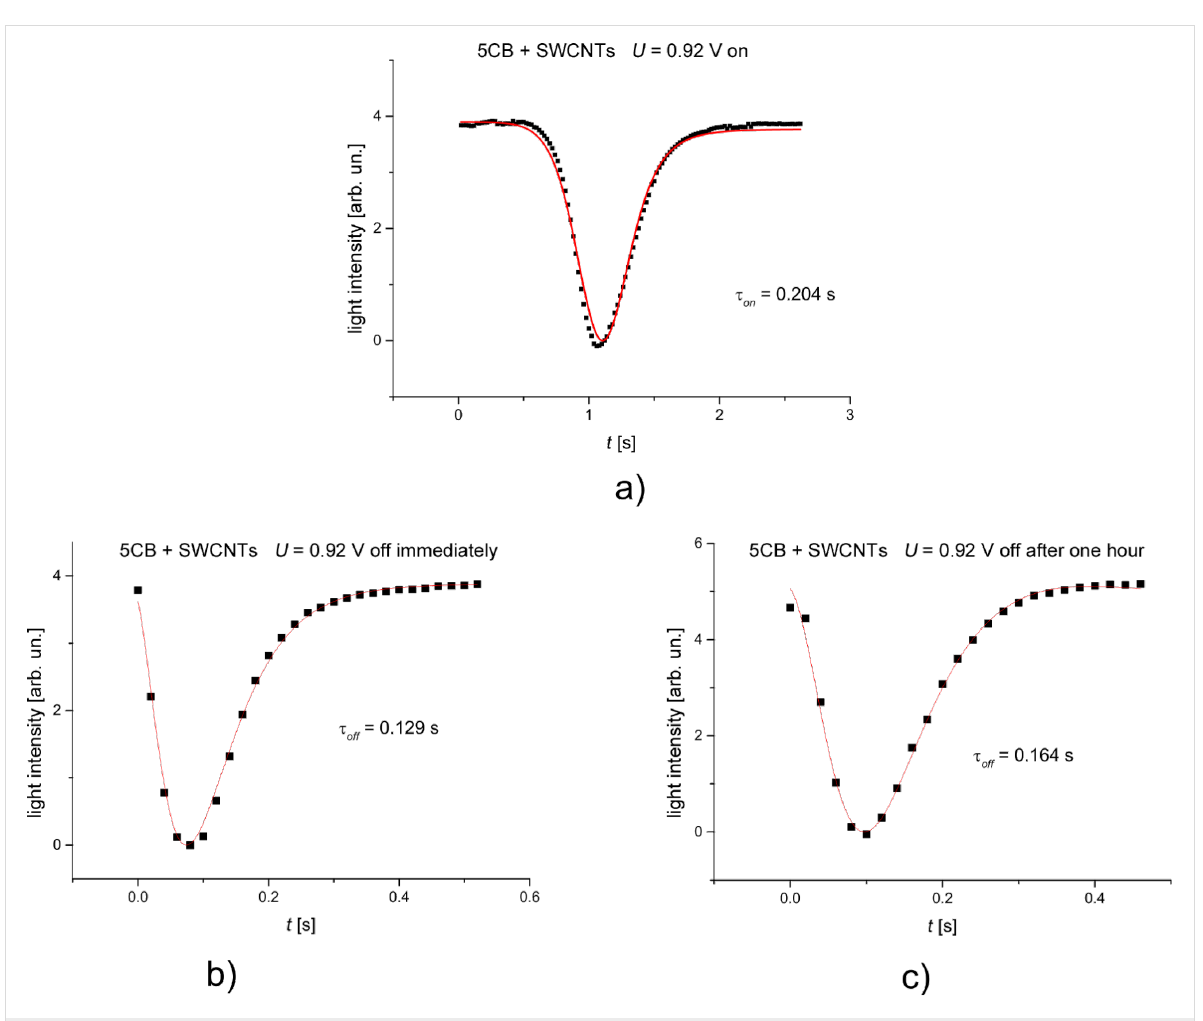
Figure 8: Variation of the intensity of a light beam traversing a cell containing LC + SWCNTs. a) The field is switched on, b) the field is switched off immediately, c) the field is switched off after one